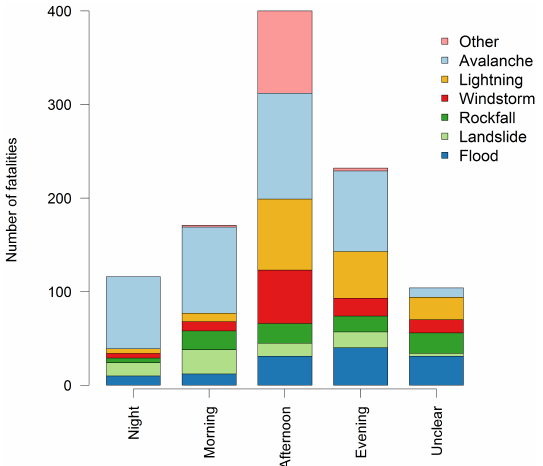
Figure 7. Distribution of natural hazard fatalities in Switzerland from 1946 to 2015 by time of day (sum over study period); morn- ing (06:00–11:59 local standard time), afternoon (12:00–17:59), evening (18:00–23:59) and night (00:00–05:59). The different colours indicate the seven process categories defined for this